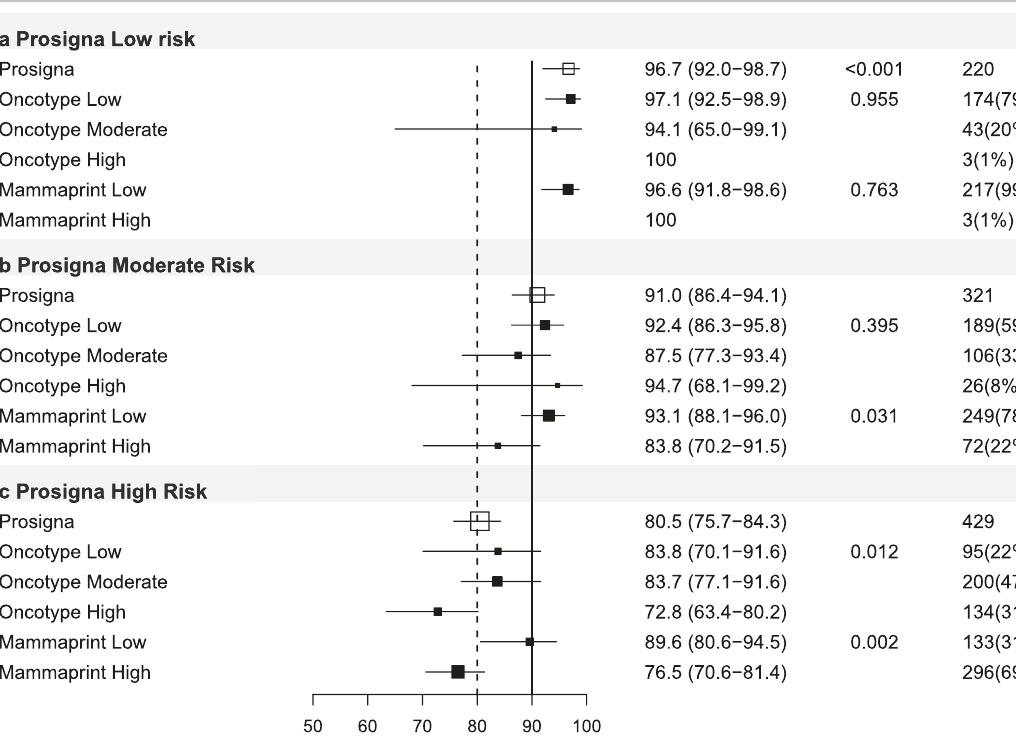
Fig. 6 Forest plot of Prosigna-trained test results re-strati fi ed by other tests, Node-ve ER + ve/HER2-ve cases treated without chemotherapy. DMFS10 = distant metastasis free survival at 10 years post diagnosis. (95% CI) = 95% con fi dence interval, P = p value, N = number of cases in each subgroup, % = percentage of cases within each risk strata, X axis = percent distant metastasis free survival. Open boxes represent primary test DMFS10 by risk group. Solid boxes represent sub-strati fi cation by secondary tests with 95% con fi dence intervals (bars). Top panel ( a ) Prosigna-trained low-risk cases strati fi ed by Oncotype-trained and Mammaprint-trained results. Middle panel ( b ) Prosigna- trained moderate risk group. Bottom panel ( c ) Prosigna-trained high risk group.